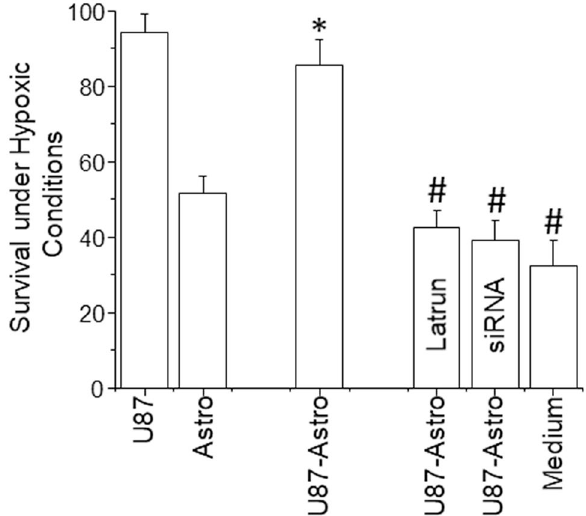
Figure 5. TNT-mediated transfer mediates adaptation to hypoxic conditions. A well-described adaptation of tumors to the microenvironment is the increased resistance to hypoxic conditions. Thus, to evaluate